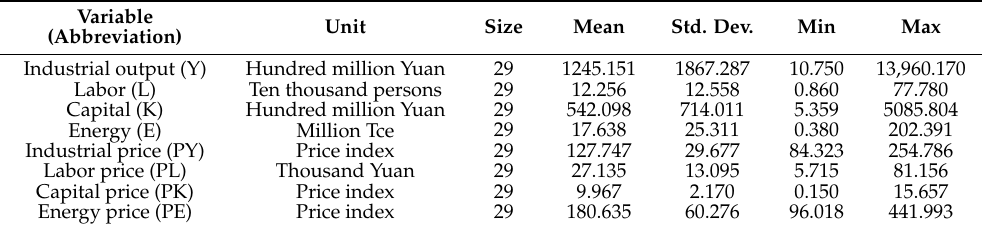
Table 1. Descriptive statistics of